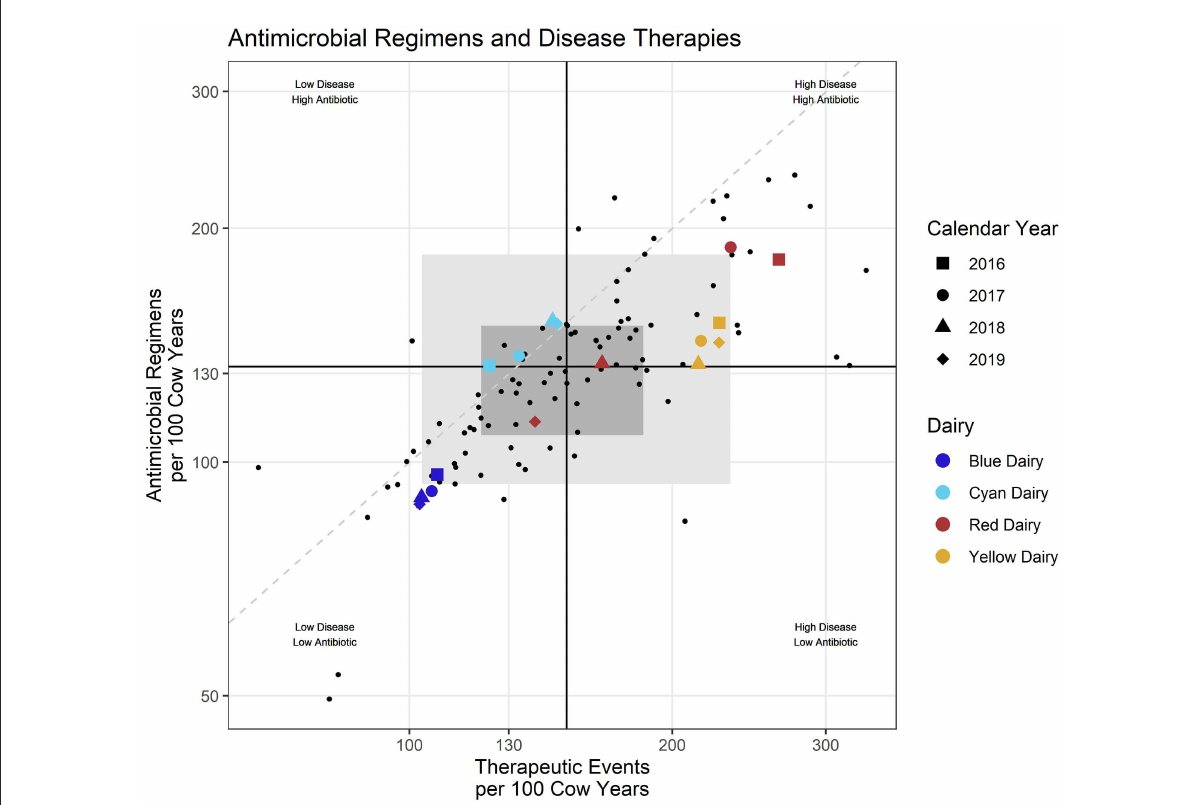
FIGURE1 Each small dot represents an individual dairy during one calendar year/Colored shapes represent selected example daries with shape indicating calendar year. Black lines represent the intersect of the medians (middle value) for the entire dataset. Dashed diagonal line provides visual reference of a 1:1 relationship between the x and y axis. Shaded rectangles represent the middle 50% (dark) and 80% (lighter) of participating dairies all years combined.